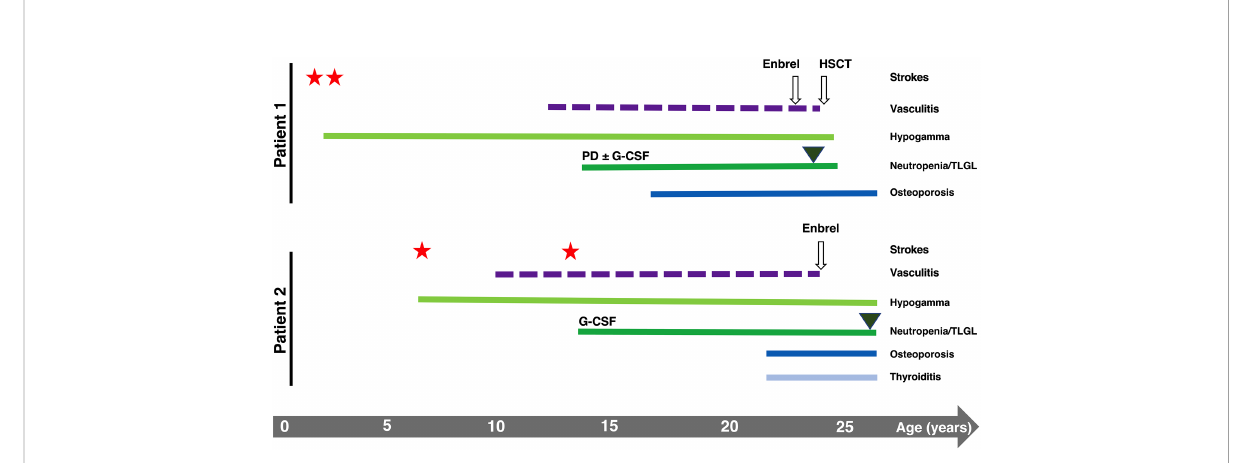
FIGURE 1 Graphical representation of the clinical history of P1 and P2. Stars and triangles represent strokes and T-LGL onset,